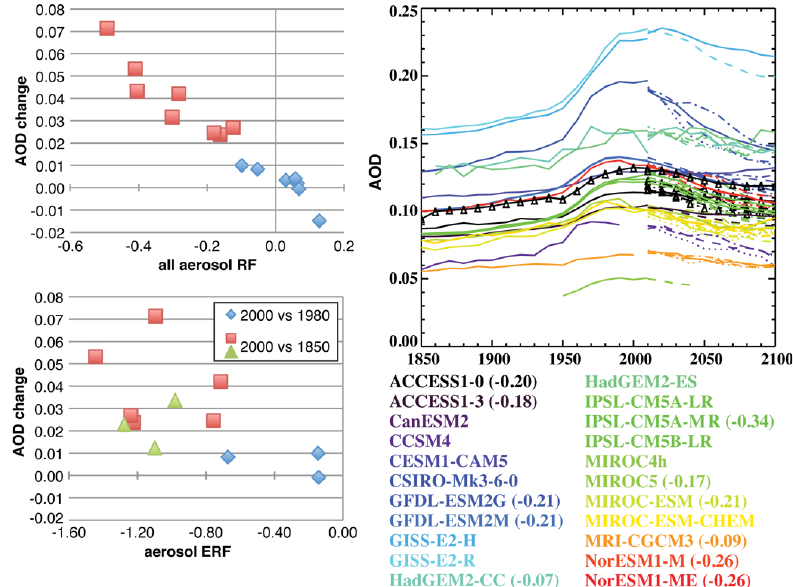
Fig. 19. AOD change versus RF (top left) and AOD change versus ERF (bottom left) from ACCMIP models (squares and diamonds) for the indicated periods. 2000 relative to 1850 ERF versus AOD changes are also shown for three additional CMIP5 models (green triangles). AOD versus time in available CMIP5 simulations (right), with estimated 2000–1850 aerosol RF given for each non-ACCMIP model for which AOD data was available. The open triangles indicate the multi-model mean. RCP2.6 is dotted, RCP4.5 dashed, RCP6.0 dash-dot, and RCP8.5